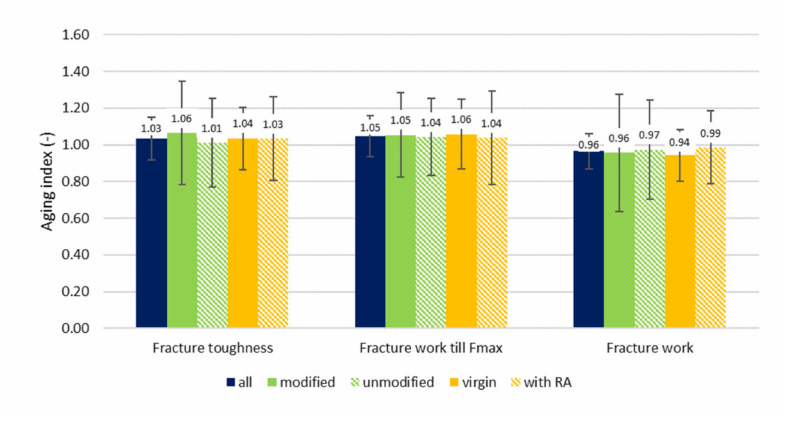
Figure 7. Average aging index—SCB test.